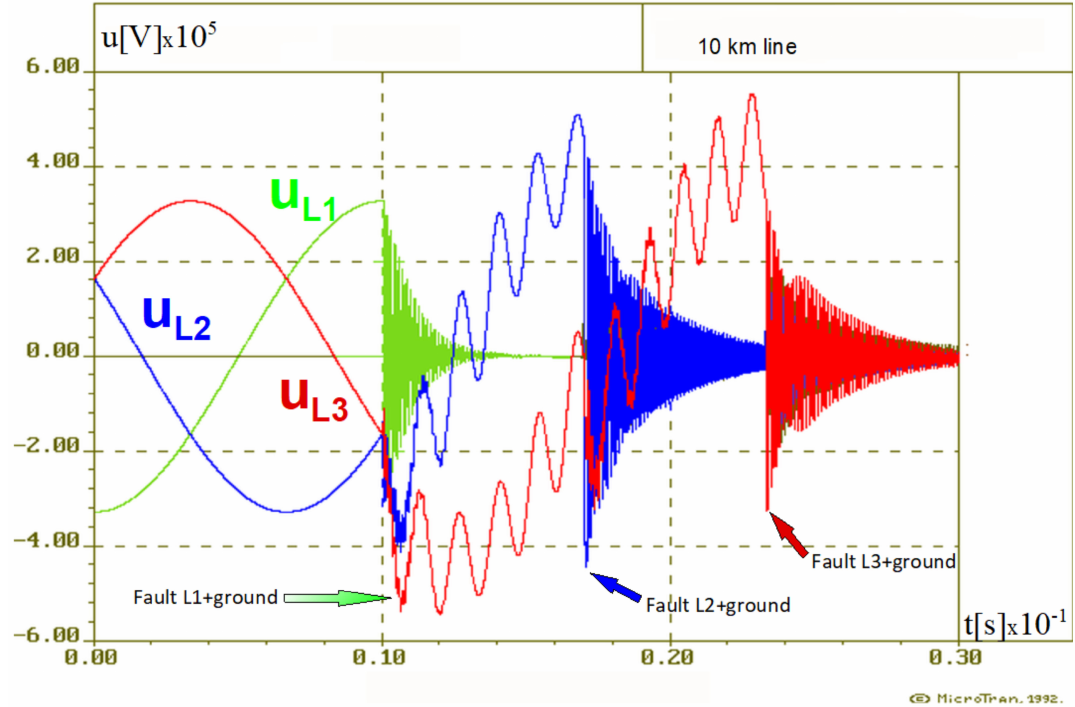
Figure 3. Transient voltages during non-simultaneous three-phase to ground